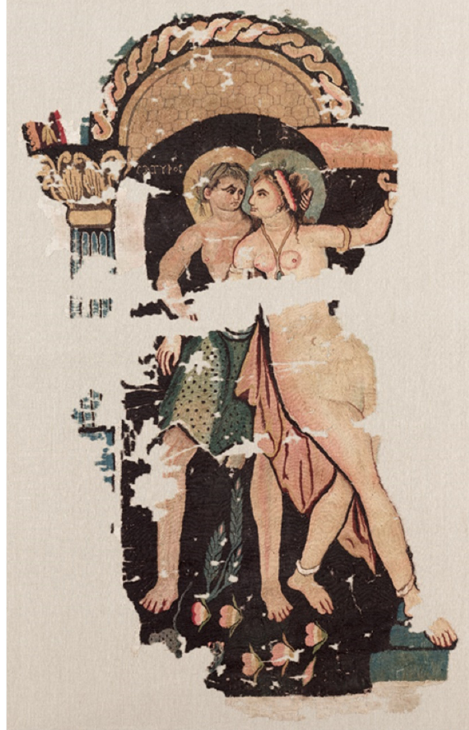
Figure 14. Fragment with Satyr and Maenad , 4th century CE. Byzantine; Egypt. Undyed linen and dyed wool; plain weave ground with tapestry weave; overall: 139 × 86.4 cm (54 3/4 × 34 in.); mounted: 153.6 × 100.4 × 3.9 cm (60 1/2 × 39 1/2 × 1 9/16 in.). The Cleveland Museum of Art, Purchase from the J. H. Wade Fund, 1975.6. Digital image available under Creative Commons license CC0 1.0.